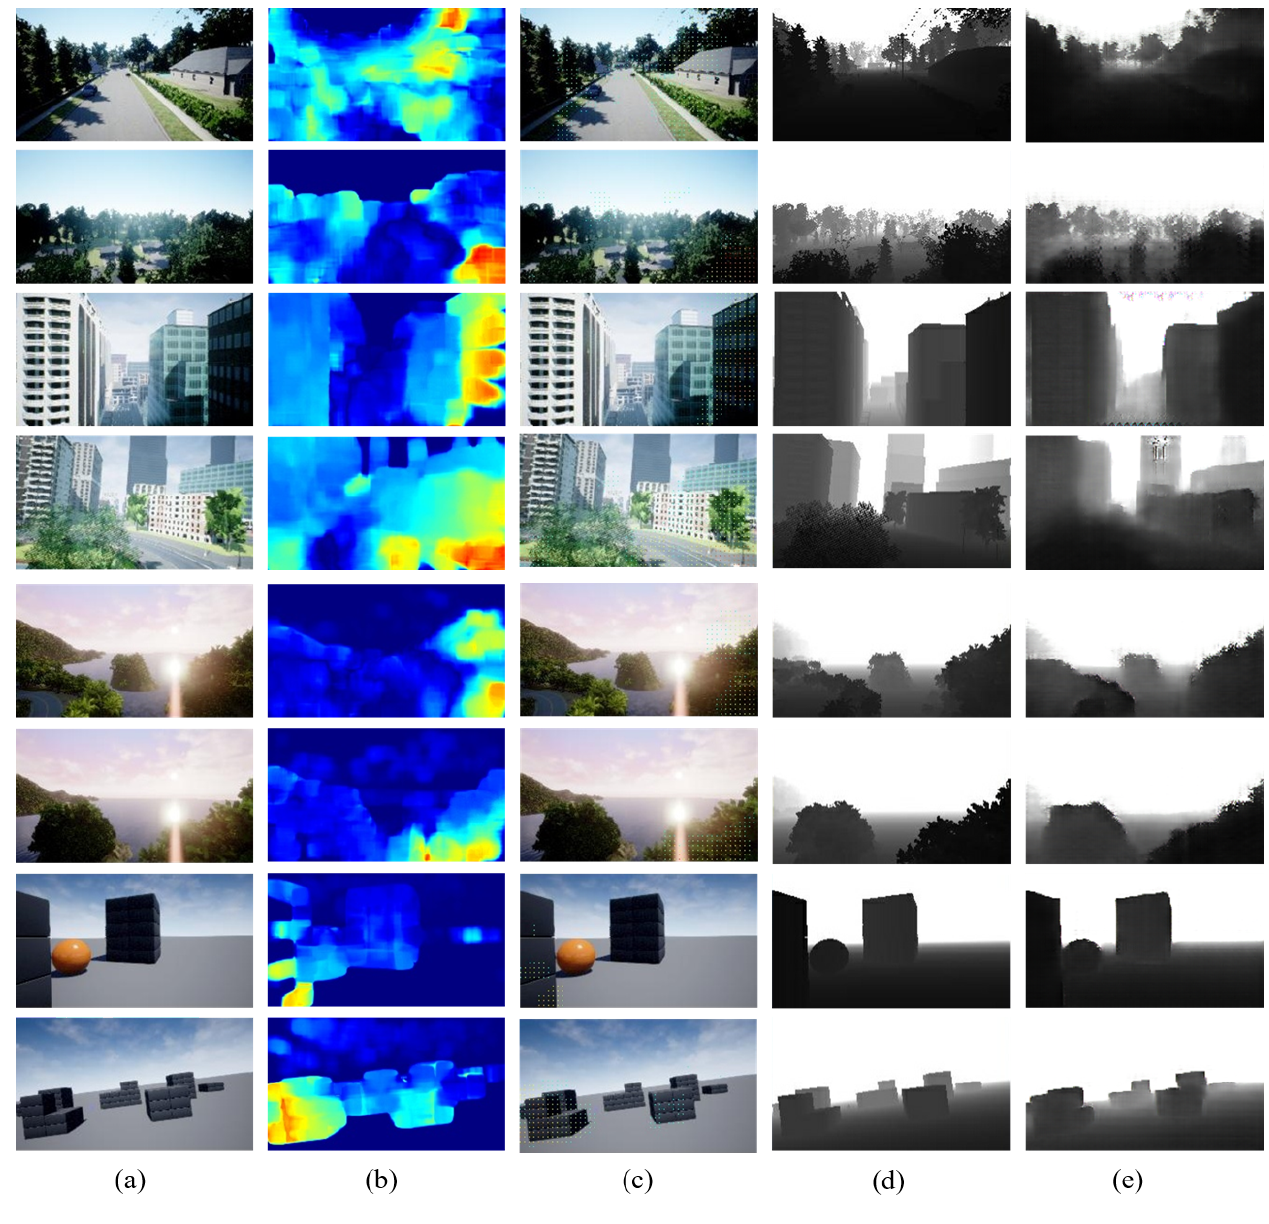
Figure 10. Inputs and outputs: ( a ) RGB images, ( b ) Optical flow maps, ( c ) RGB images embedded with optical flow map, ( d ) Ground truth, ( e ) Depth estimation